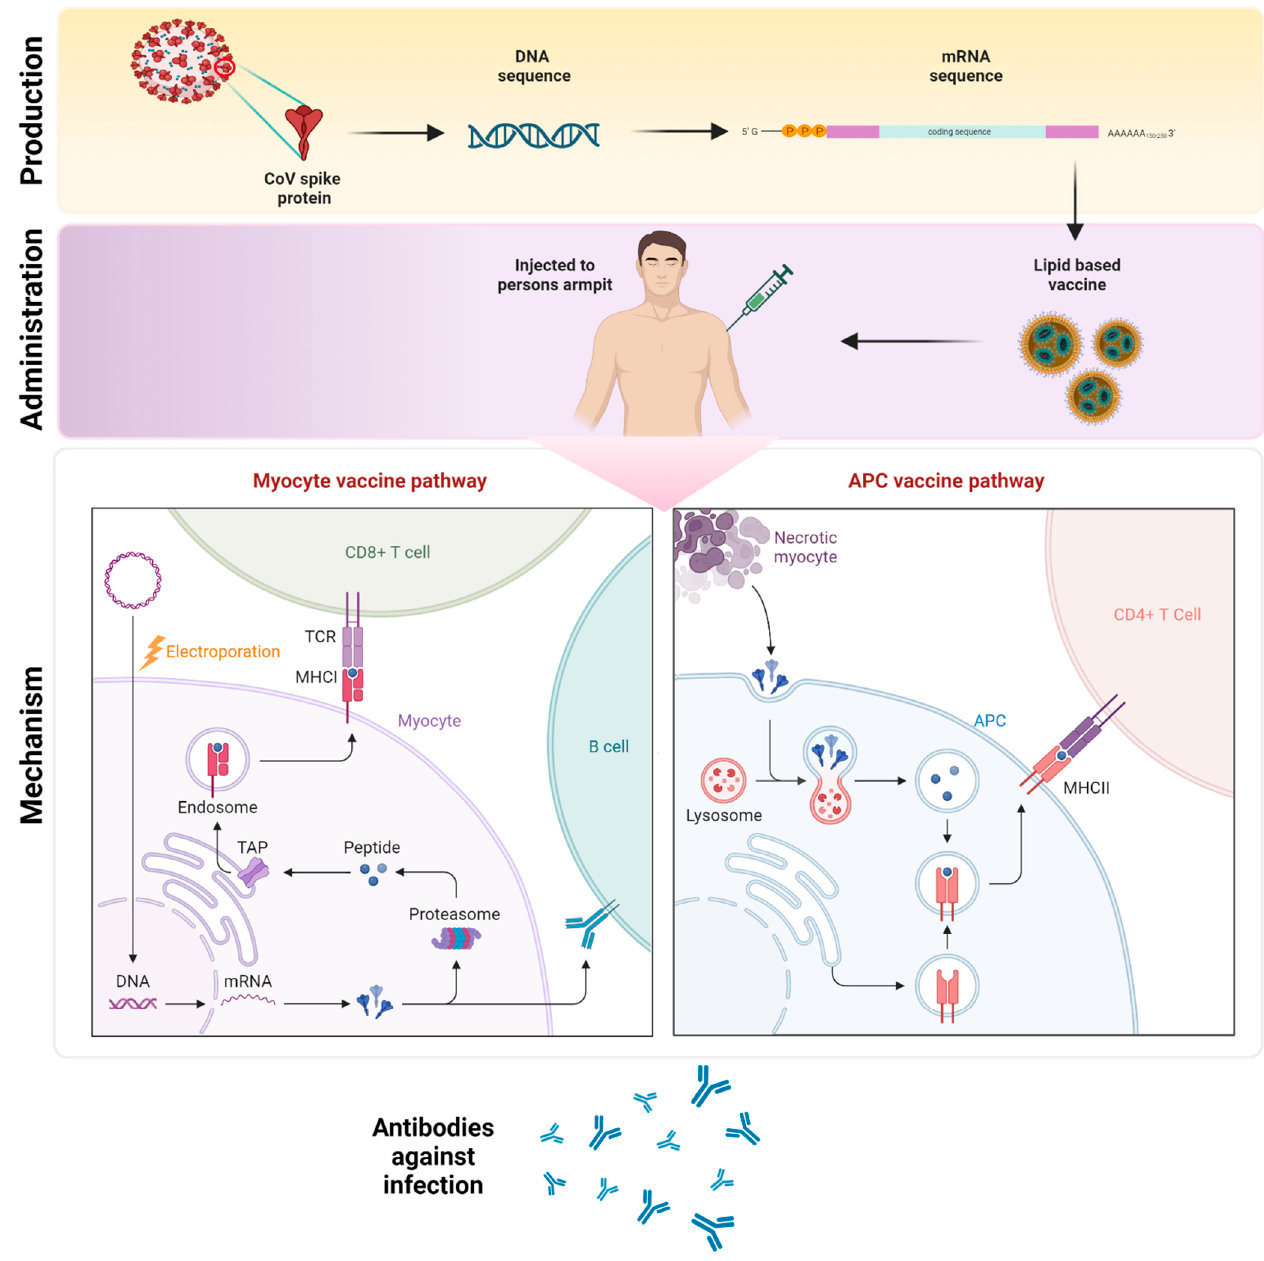
Figure 7. Mechanism through which mRNA Vaccine elicit immunity to the host. (Created with BioRender.com accessed on 1 January 2023).